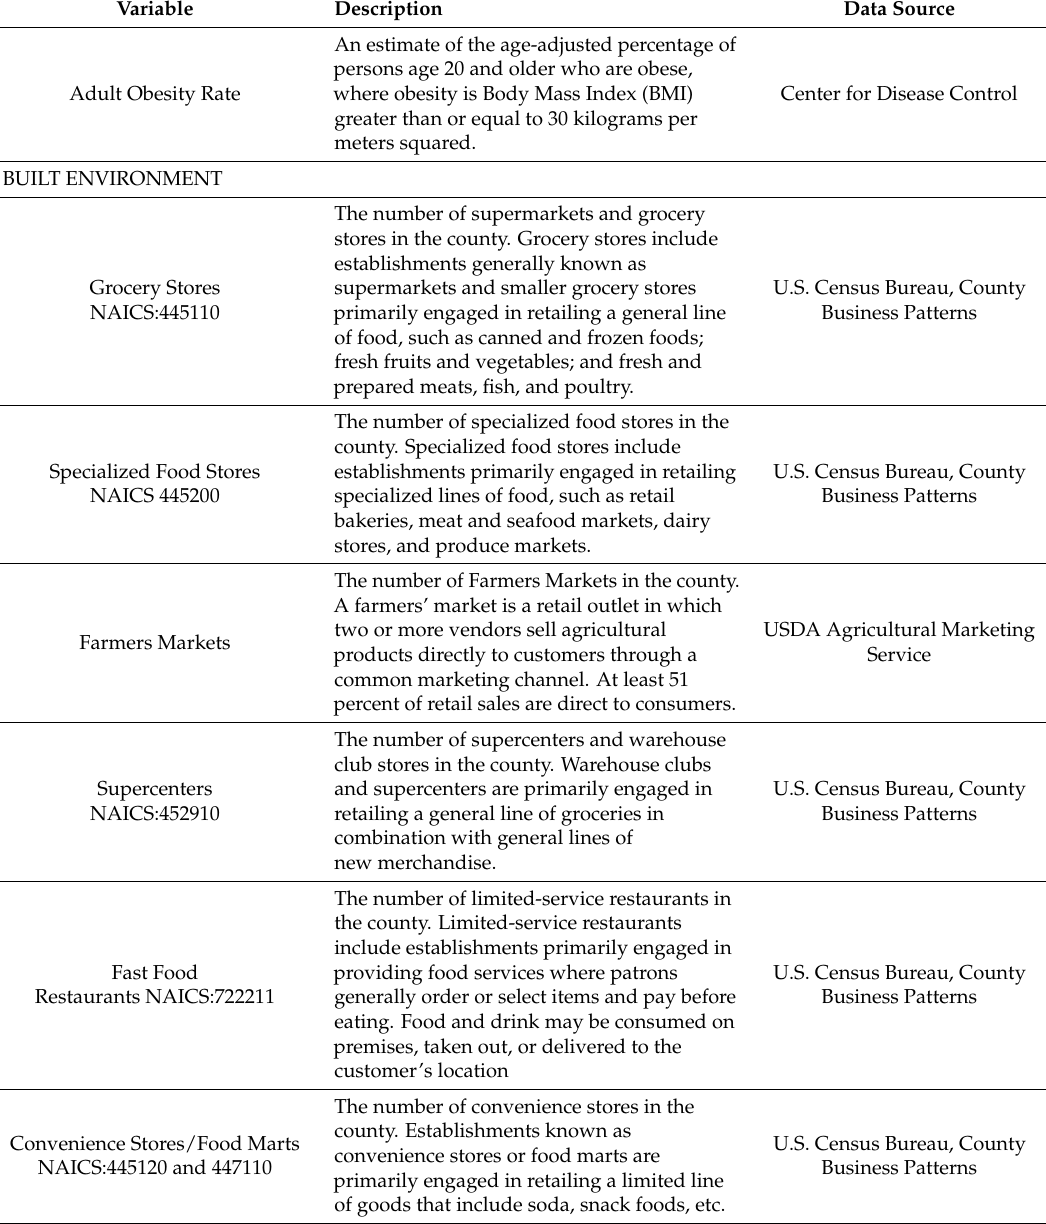
Table A1. Definitions for adult obesity rate & food environment